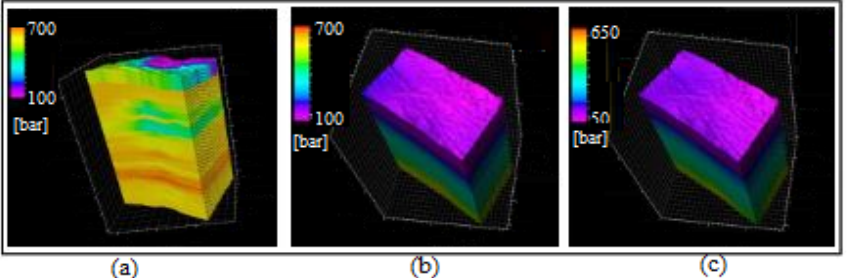
Figure 11. Simulation results: ( a ) vertical stresses (bar), ( b ) maximum horizontal stress (bar), ( c )